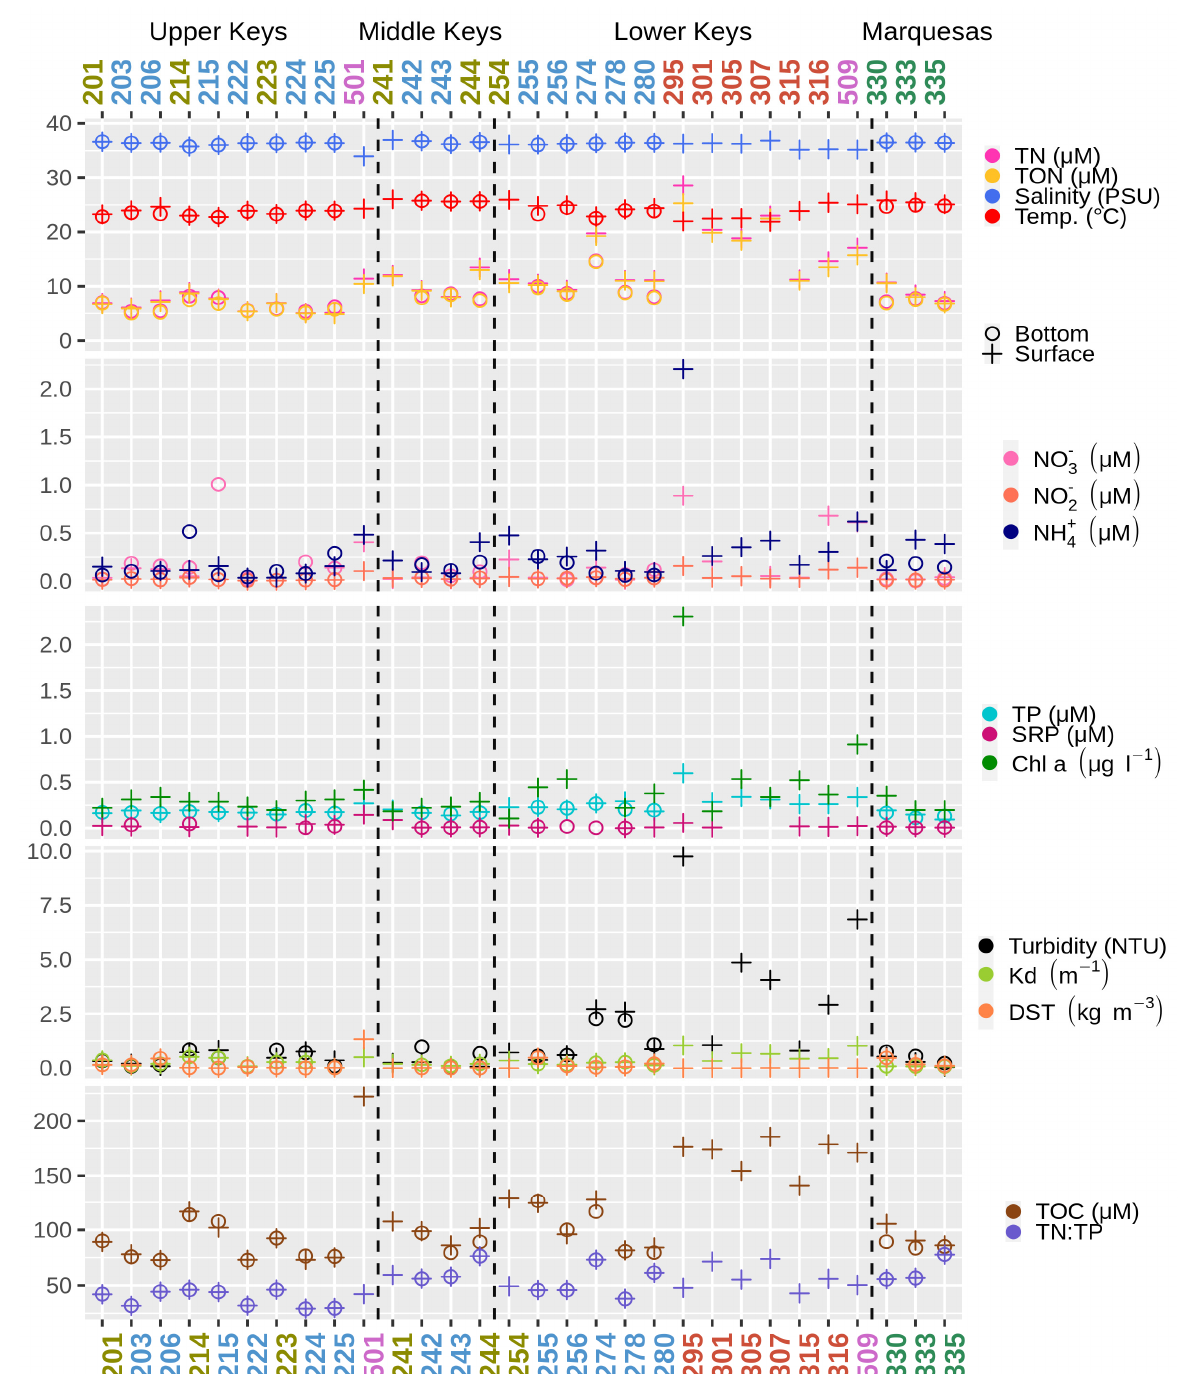
Figure 2. Physicochemical parameters of the water samples: total nitrogen (TN), total organic nitrogen (TON), nitrate, nitrite, ammonium, total phosphorus (TP), soluble reactive phosphorus (SRP), chlorophyll a (Chl a), diffuse attenuation coefficient (Kd), Delta Sigma-T (DST), total organic carbon (TOC) and total nitrogen to total phosphorus ratio (TN:TP). The color code for the stations follows Figure 1.